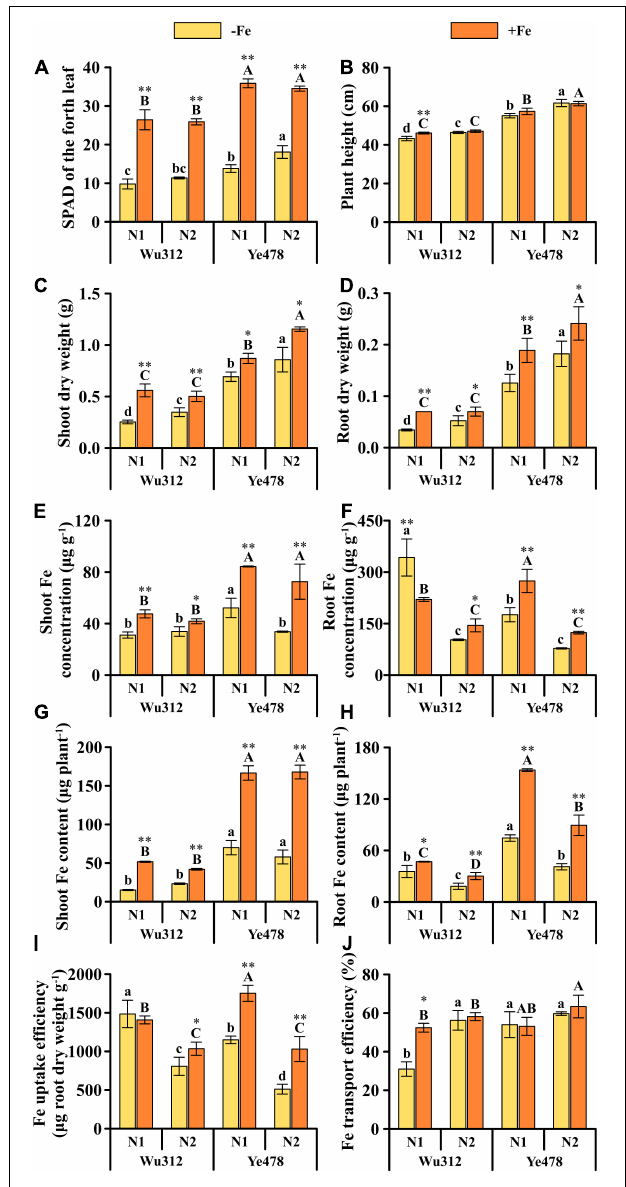
FIGURE 4 | SPAD value of the fourth leaf (A) , plant height (B) , shoot (C) and root dry weights (D) , shoot (E) and root Fe concentrations (F) , shoot (G) and root Fe contents (H) , and Fe uptake (I) and transport efficiencies (J) of Wu312 and Ye478 under Fe-deficient [–Fe: 30 µ M Fe(III)-EDTA] and Fe-sufficient conditions [+Fe: 200 µ M Fe(III)-EDTA] supplied with N1 [Ca(NO 3 ) 2 : 2 mM NO 3 − -N] or N2 [NH 4 NO 3 : 2 mM NO 3 − -N, 2 mM NH 4 + -N]. Different lowercase and upper letters indicate significant difference ( p < 0.05) of inbred lines under –Fe and +Fe conditions, respectively. * and ** indicate significant difference between the –Fe and +Fe treatments at p < 0.05 and p < 0.01,